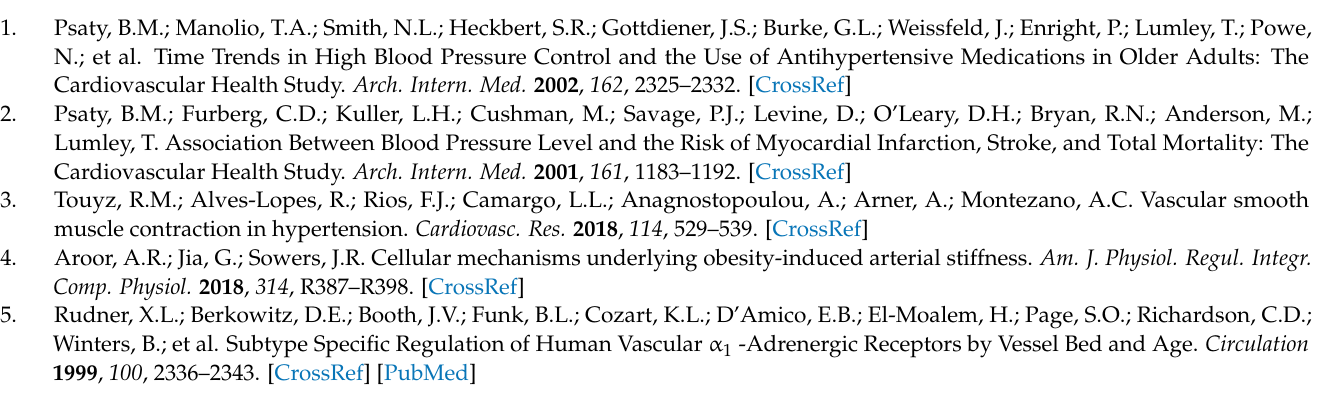
description; Table S2: scRNAseq integrator clusters; Table S3: Donors noradrenaline-dependent sensitization ability with BMI less than 30; Video S1: Calcium signaling in